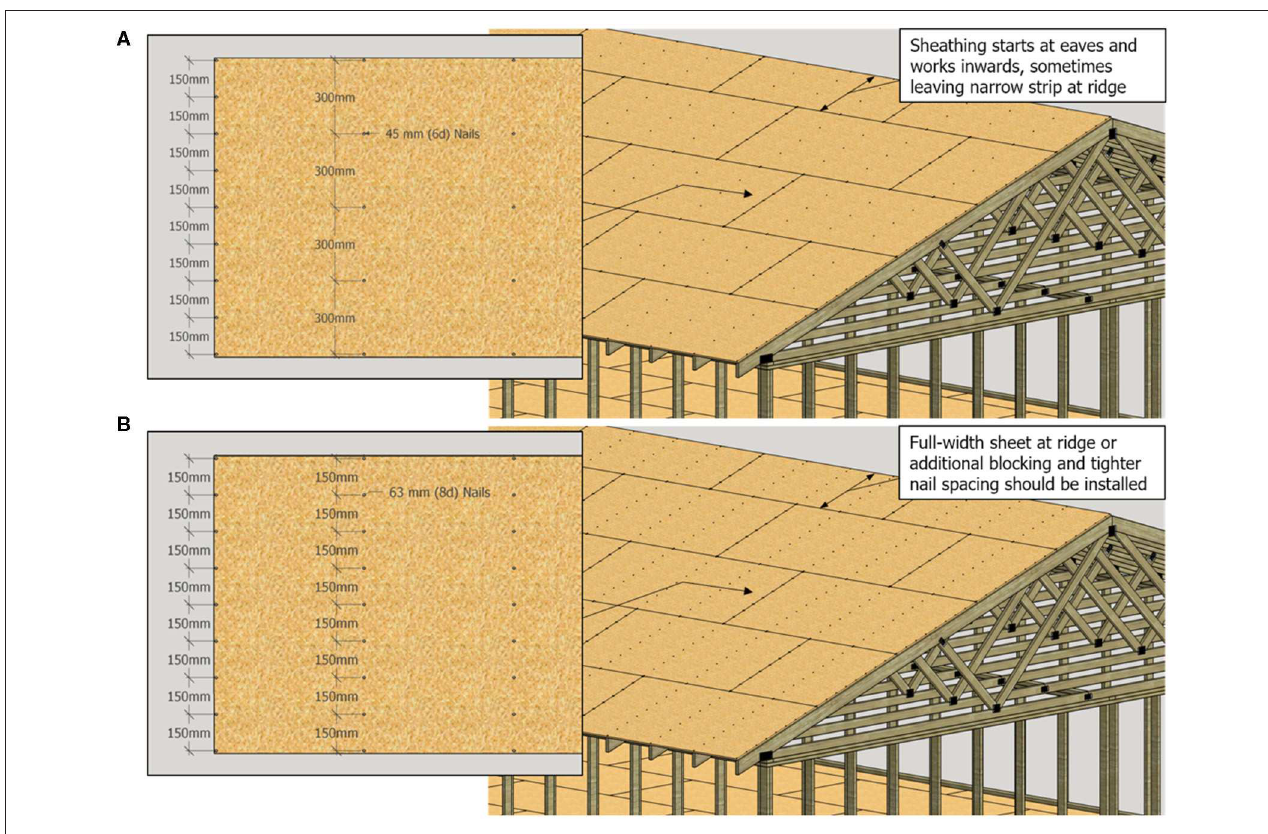
FIGURE 4 | (A) Sheathing fastener requirements per NBCC part 9.23.3.5. (B) Recommended sheathing fasteners and panel placement